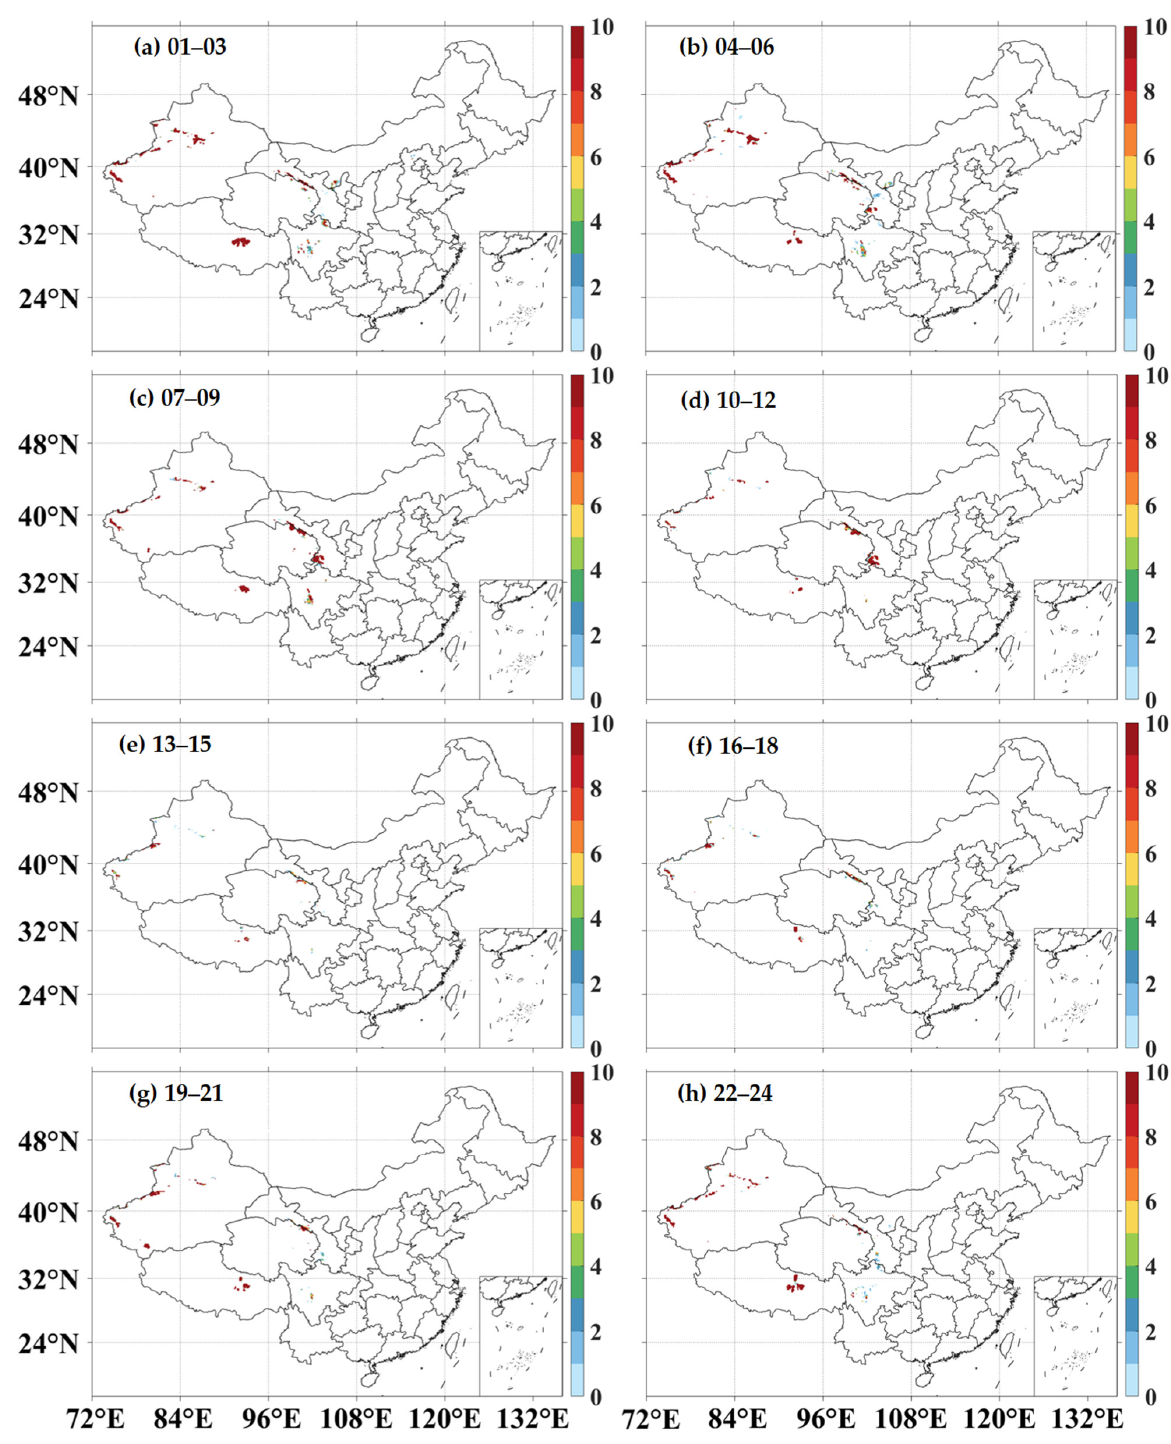
Figure 14. Diurnal variation of frequency (%) distribution of snow for period LST 01–03, 04–06, 07–09, 10–12, 13–15, 16–18, 19–21, and 22–24 in June from 2018 to 2021.